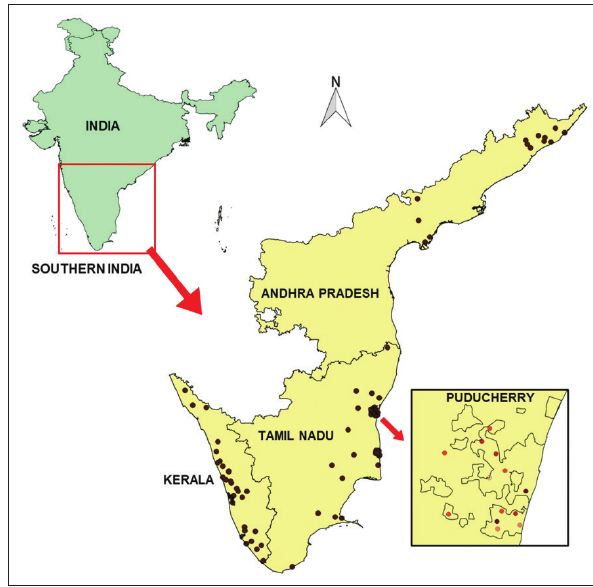
Figure-1: The surveyed Epi units (villages) location is depicted (as ● a dot) in the GIS Map (using QGIS version 2.18.0) of the studied administrative division in the southern peninsular region of